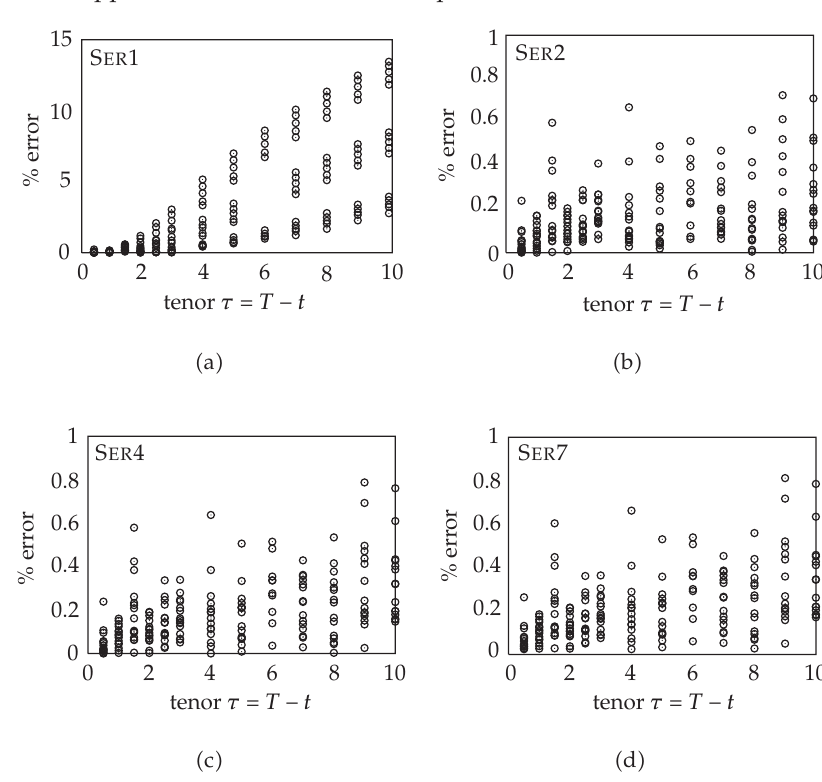
Figure 2.1 . Percentage error in the value of a call option using series ( 1.3 ) for a number of sample runs. ( a ) 1 term in the series; ( b ) 2 terms; ( c ) 4 terms; ( d ) 7